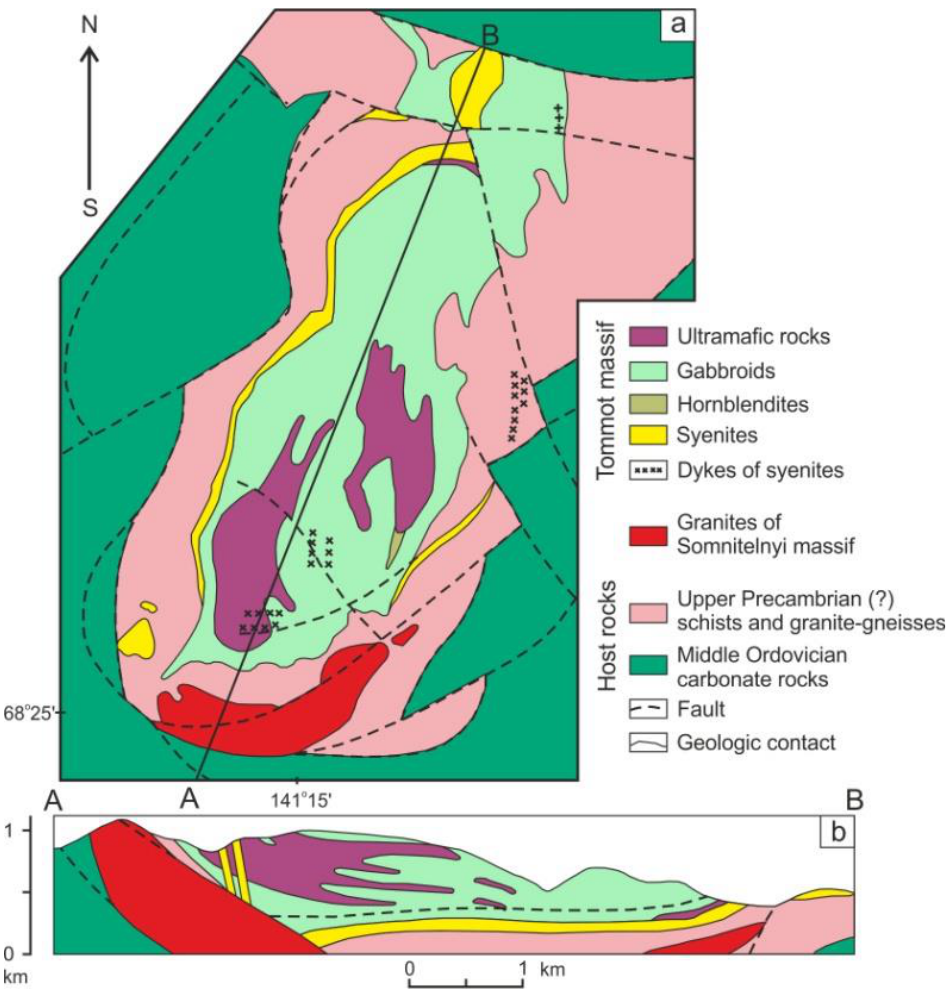
Figure 3. ( a ) Schematic map of the Tommot and Somnitelnyi massifs; ( b ) geological cross-section (A,B) [modified from 27]. For location, see Figure 2.